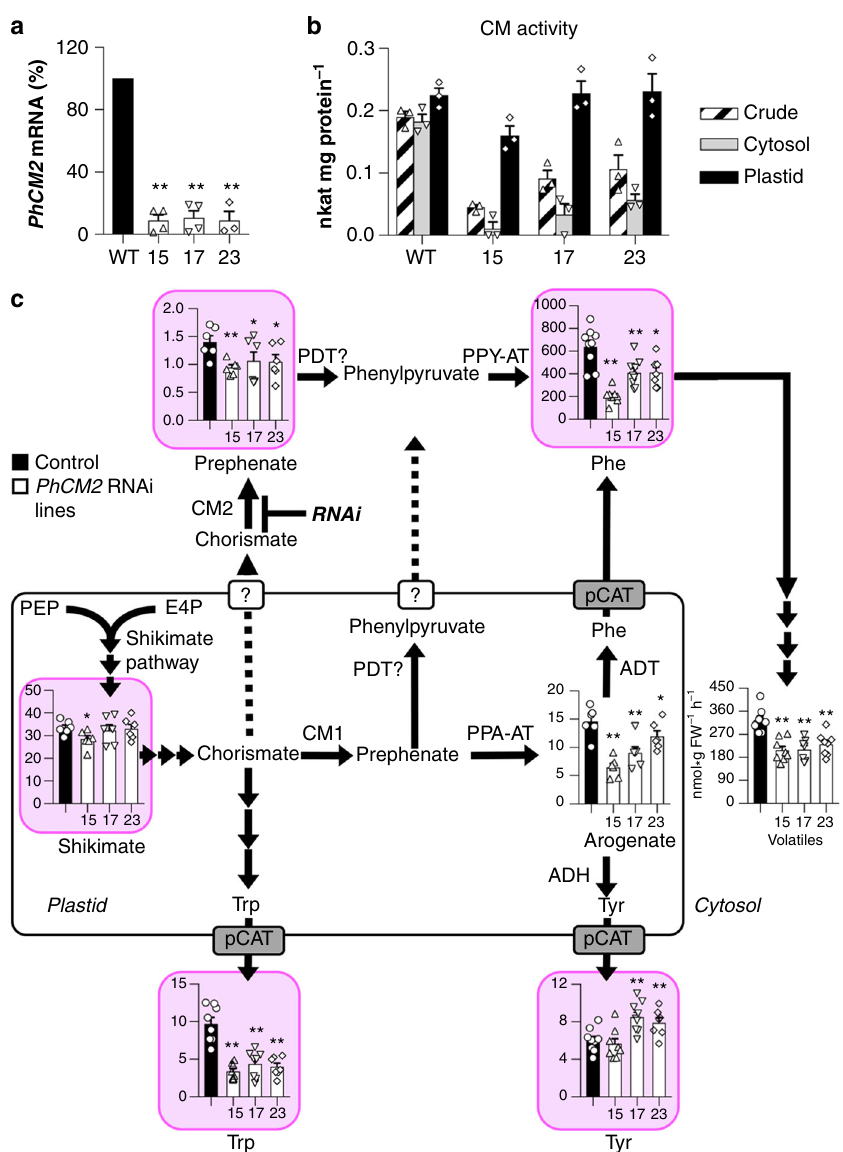
Fig. 2 Metabolic effects of PhCM2 RNAi downregulation in petunia fl owers. a PhCM2 mRNA levels in 2-day-old petunia petals at 20:00 h. Expression levels in transgenic lines (white bars) are shown as a percentage of PhCM2 expression in control (black bar) petals set as 100% ( n ≥ 3 biological replicates). b CM activities with 500 μ M chorismate in crude extracts (striped bars), and cytosolic (gray bars) and plastidial (back bars) fractions prepared from corollas of 1- to 3-day-old wild type and PhCM2 RNAi petunia fl owers harvested at 10:00 h ( n = 3 biological replicates). c Internal pools of shikimate, prephenate, arogenate, and aromatic amino acids as well as total volatile emission ( n ≥ 6 biological replicates). Metabolite levels were measured in 2-day- old petunia petals at 20:00 h and are shown in nmol/gFW. Pink background indicates metabolites with potential dual subcellular localization, in the cytosol and plastids. Emitted volatiles were collected from 2-day-old wild-type and transgenic PhCM2 RNAi petunia fl owers from 18:00 h to 22:00 h. Black and white bars represent wild-type and transgenic lines, respectively. Data are means ± SE. *P < 0.05, ** P < 0.01 as determined by paired two-tailed Student ’ s t- test. ADT arogenate dehydratase, ADH arogenate dehydrogenase, CM chorismate mutase, E4P erythrose 4-phosphate, pCAT